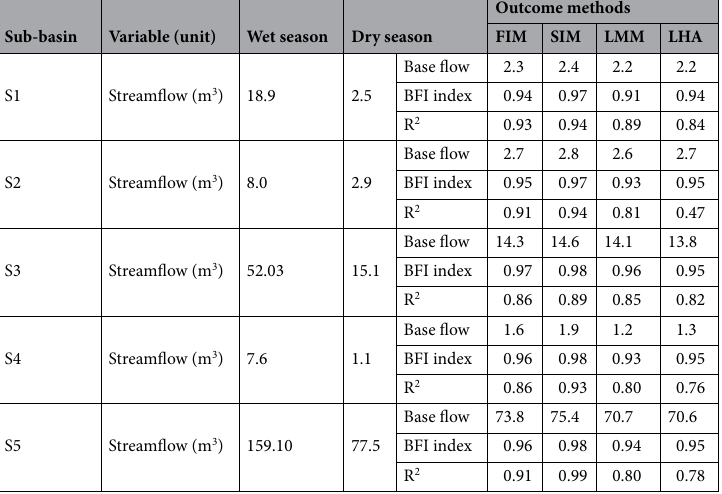
Table 3. Average Streamflow over the wet and dry seasons and outcome of baseflow